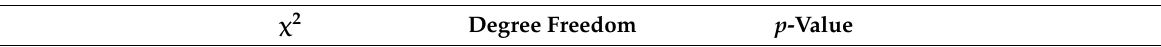
Table 3. Result of Generalized Linear Mixed Model on emission rate among non-agonistic Interaction (Int), Body Movements (BodyMov), and Agonistic Interaction (AgoInt) behavioural events including the replicates as random